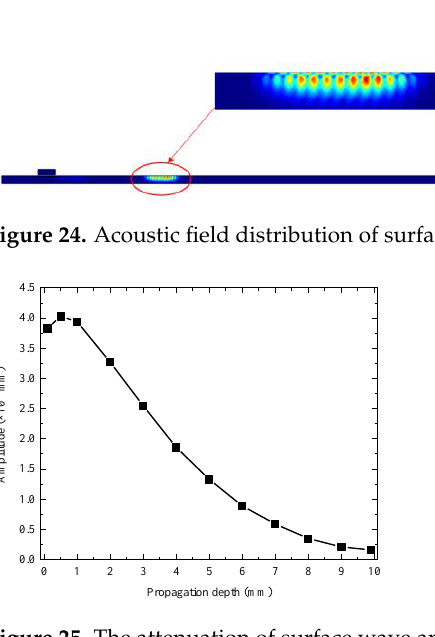
Figure 25. The attenuation of surface wave amplitude with the propagation depth.